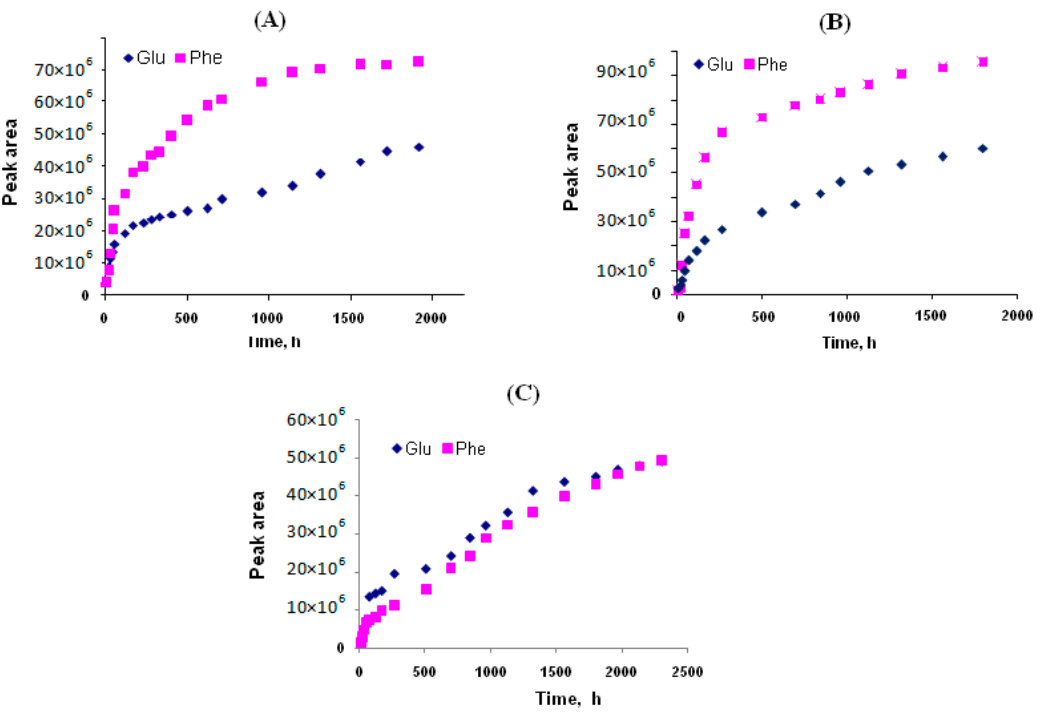
Figure 8. Accumulation of free amino acids during the biodegradation process of PGlu- b -PPhe polymersomes at physiological conditions (pH 7.4, 37 °C). ( A ) degradation of GP1 using papain; ( B ) degradation GP3 using papain; and ( C ) in vitro degradation of GP3 using blood serum plasma.